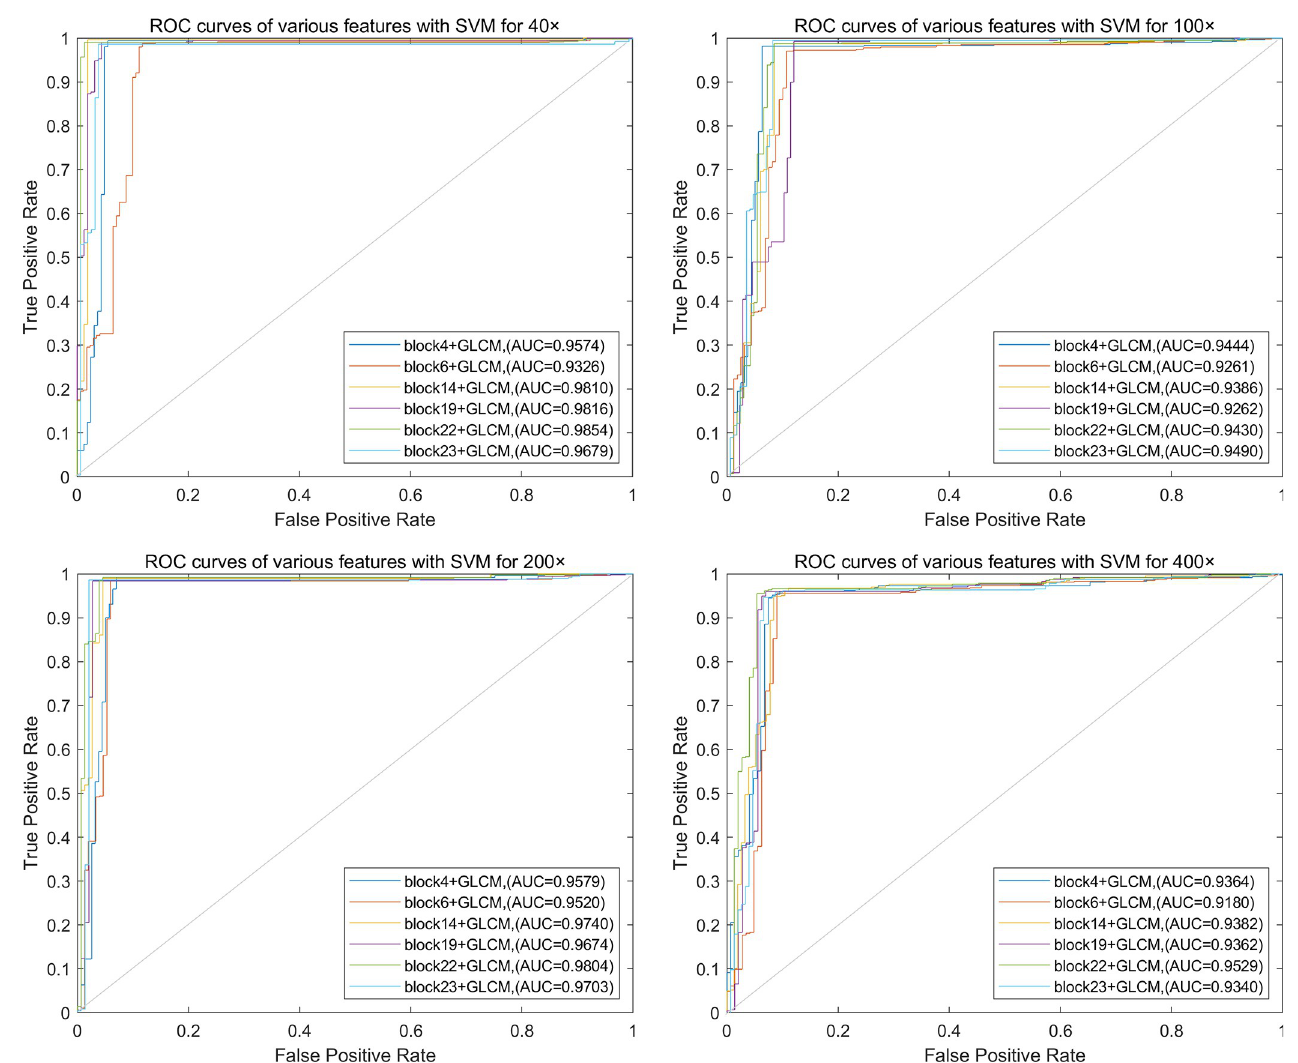
Fig 5. ROC curves of different feature combinations for MSB classification. (a) 40 × , (b) 100 × , (c) 200 × , (d) 400 ×